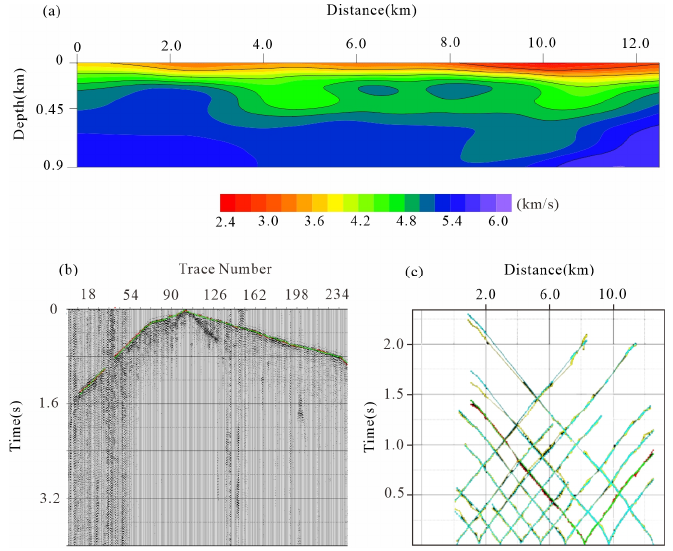
Figure 7. Schematic showing the results for the ( a ) travel time tomography and ( b , c ) travel time fitting of the seismogram during tomography inversion, comprising the seismogram after band- pass filtering, including the first break picking travel time (red point) and fitting travel time (green point), the picking travel time (yellow point), and the inversion fitting travel time (green point) of all ten shot